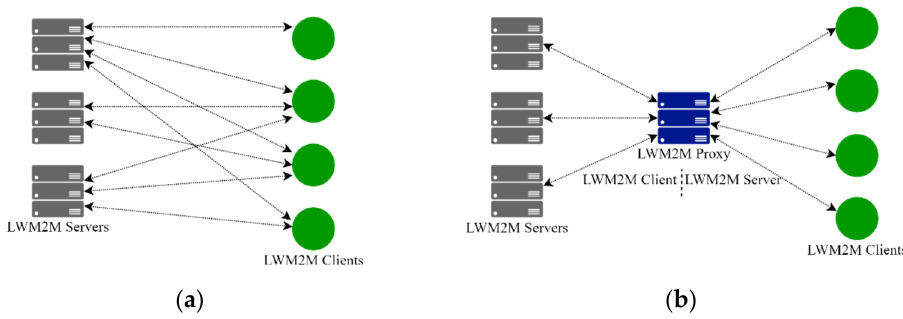
Figure 1. LWM2M Architecture, ( a ) without LWM2M Proxy, ( b ) with LWM2M Proxy.